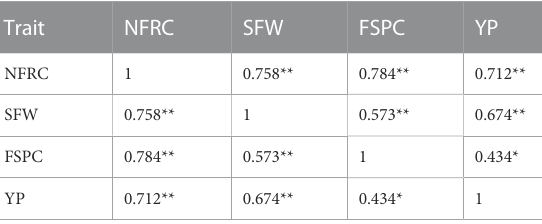
that DM (50%), YP (kg), and SFW (g) are correlated with each other, while PH, FSPC, NFC, and NFRC also had a signi fi cant association with each other. DF (50%) had a positive correlation with NBP and a negative correlation with all other variables, while NLF and NCP exhibited a positive association with each other (Figure 3). In scree plot analysis, the eigenvalues are displayed on the y -axis and the number of components on the x -axis. It shows a downward curve. The point where the slope of the curve is visibly fl attening off (the “ elbow ” ) speci fi es the number of factors the analysis should create. In the current scree plot, PC1, PC2, PC3, and PC4 should be retained in exploratory analysis to keep in PCA, and the rest behind the fi rst three components are disregarded (Figure 4). Correlation represents the inter-relationship between two traits. The correlation of NFRC, SFW, FSPC, and YP showed different ranges from signi fi cantly positive to highly signi fi cant and positive. In the correlation coef fi cient analysis, NFRC showed a highly signi fi cant positive correlation with SFW (0.758**), FSPC (0.784**), and YP (0.712**). SFW exhibited a highly signi fi cant positive association with NFRC (0.758**), FSPC (0.573**), and YP (0.674**). Likewise, FSPC showed a highly signi fi cant correlation with NFRC (0.784**) and SFW (0.573**) and a signi fi cant positive association with YP (0.434**). A highly signi fi cant positive correlation (0.712** and 0.674**) was recorded for YP with NFRC and SFW and a signi fi cant positive correlation with FSPC (0.434*) (Table 3). The positive correlation of NFRC, SFW, FSPC, and YP indicated that YP could be improved by directly selecting these traits.